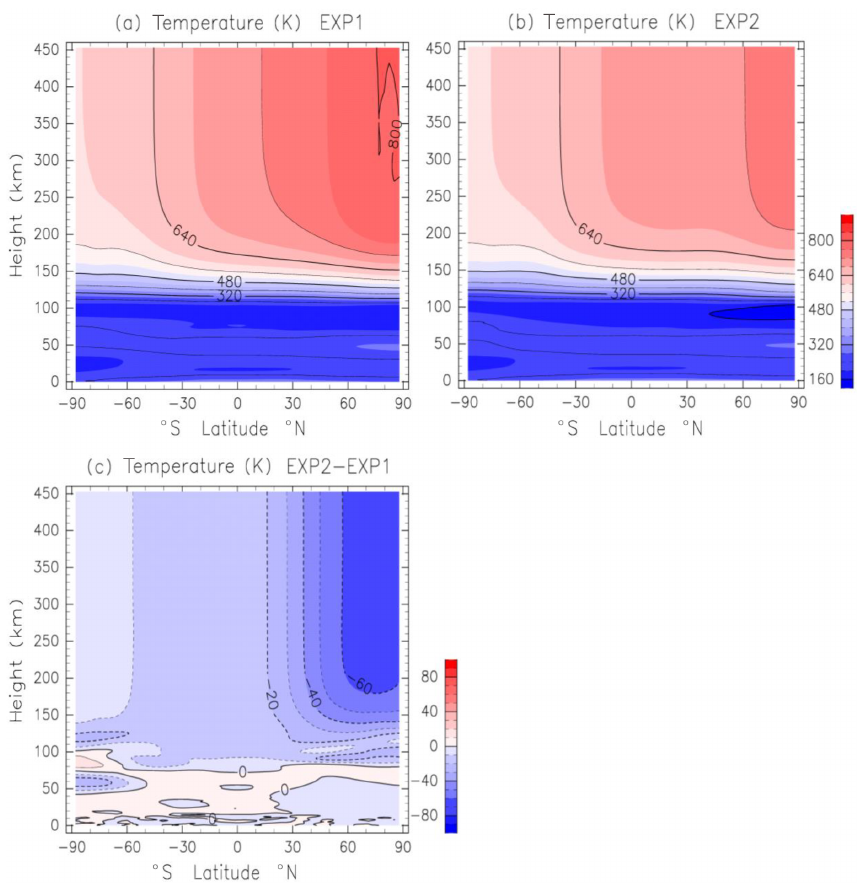
Figure 3. (a) Zonal-mean temperature obtained by EXP1 (Lindzen’s parameterization below 100km height). Data are averaged from 1 to 30 June. Units are kelvins. (b) As in (a) except for EXP2 (Yi˘git’s parameterization in the whole atmosphere). (c) Temperature difference between EXP1 and EXP2 (EXP2–EXP1). Contour intervals are